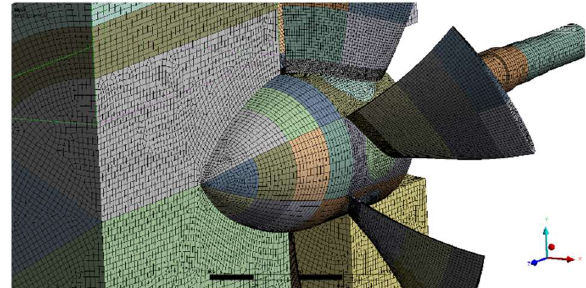
Fig. 7 Acoustic modal analysis – computational mesh The shaft, fully connected to the runner, was fixed in the bearings by displacement boundary conditions. All degrees of freedom were fixed except the rotation around shaft axis. The FSI interface was applied on the surface where the hub and runner are in contact with water. The zero acoustic pressure was applied at the inlet and outlet of the domain.